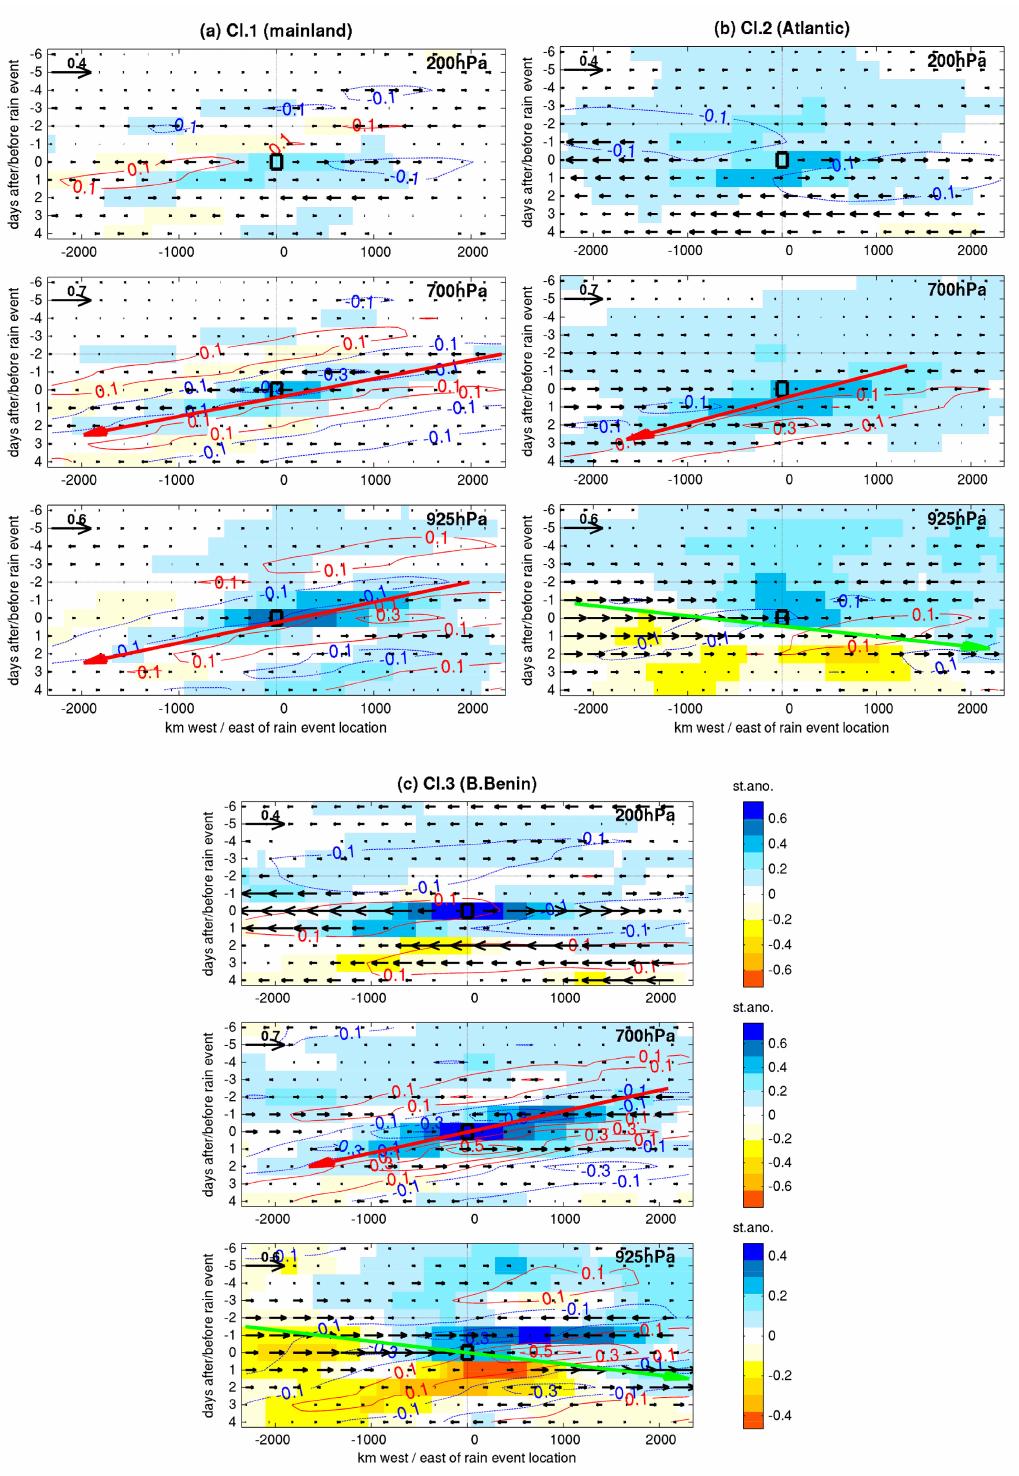
Figure 14. Time-longitude plots of zonal wind (black vectors), meridional wind (contours) and specific humidity (shading) anomalies, for intense rainfall events belonging to cluster 1 (7–8 ◦ N, panel a ), cluster 2 (4–5 ◦ N, panel b ) and cluster 3 (4–5 ◦ N, panel c ). Time varies from 6 days before (d-6) to 4 days after (d4) the intense rainfall event (d0). The x-axis shows distances west and east of point P where the intense event occurs (black square). Positive meridional wind anomalies are in red (southerlies) and negative anomalies in blue (northerlies). Large arrows show approximate westward (red) and eastward (green) propagations based on zonal wind and humidity